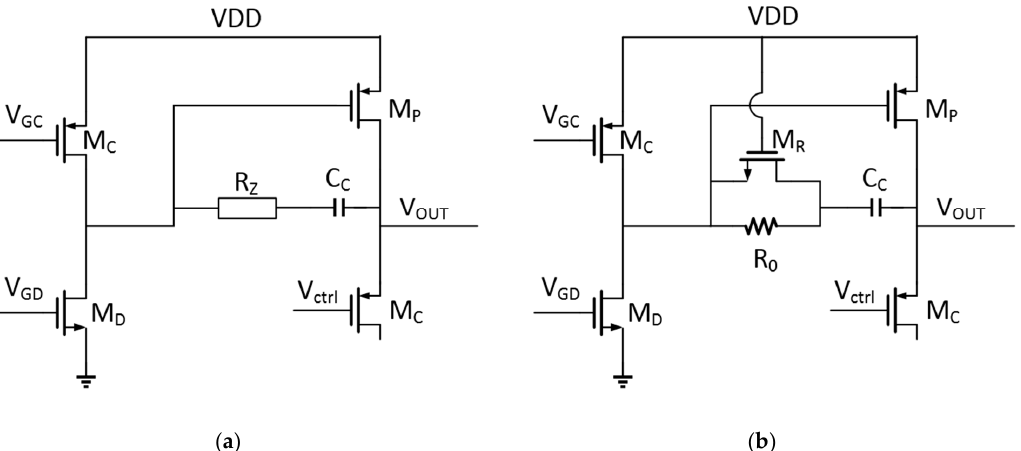
Figure 6. ( a ) The traditional Miller compensation. ( b ) Miller compensation with ARU. However, when the output current is little, there is huge difference between the reciprocal of the actual transconductance of the power transistor and the actual equivalent resistance of M R . The reason for this is that the above equation is accurate only when the power transistor M P is operating in the saturation region and transistor M R is operating in the linear region. In most cases, the above two assumptions are true, except when the output current is very small. At light loads, the power transistor M P is in the subthreshold region and M R turns off. Therefore, both the transconductance of M P and the equivalent resistance of M R deviate from the calculated value, especially the latter. The equivalent resistance of M R in the cut-off region is much larger than that in the linear region. Consequently, a resistor R 0 is paralleled across the M R . This structure is named adaptive resistance unit (ARU). When I O is small, the resistance of ARU, R Z is approximately equal to R 0 , and conversely, when I O is large, R Z is approximately equal to R M . R 0 can effectively solve the problem of mismatch between the zeroing resistor and the transconductance of the power transistor at light loads. The comparison of 1/g m and R Z over the entire load current range is shown in Figure 7, and it was clear that their values were close in the whole load range. Additionally, the amplitude-frequency curve and phase-frequency curve using ARU and the fixed resistor are shown in Figure 8, it can be observed that when the fixed resistance was used as zeroing resistance, there was a right half-plane zero point located in the low frequency region at light loads, and there was a left half-plane zero point within the bandwidth at heavy loads. However, when ARU was used as the zeroing resistor, there were no zeros or poles except the main pole located within the bandwidth. So, it was proved that ARU had a significant improvement in loop stability.